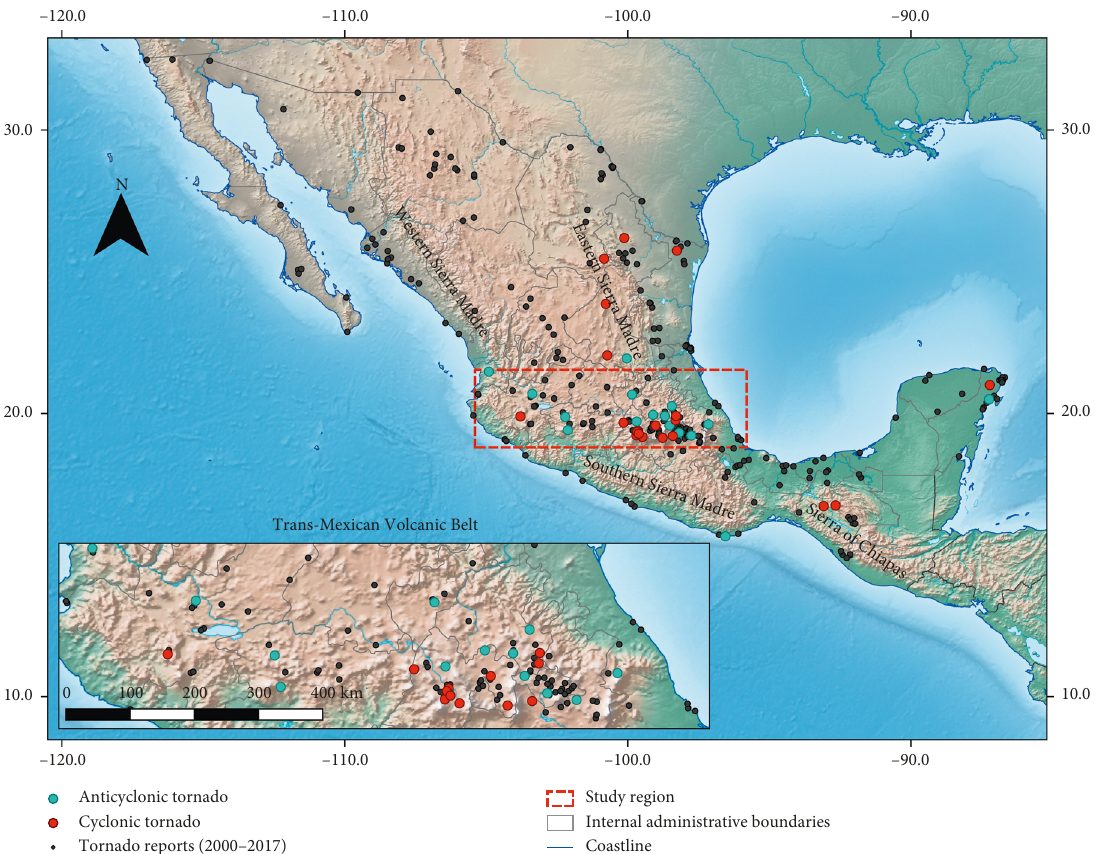
Figure 1: Orography of Mexico and spatial distribution of tornadoes originating from 2000 to 2017. The box indicates the region of the Trans-Mexican Volcanic Belt. Cyclonic and anticyclonic tornadoes are marked with red and blue circles, respectively. The names of several important mountain ranges are also indicated. Tornado reports were collected from a previous climatology [25] and our